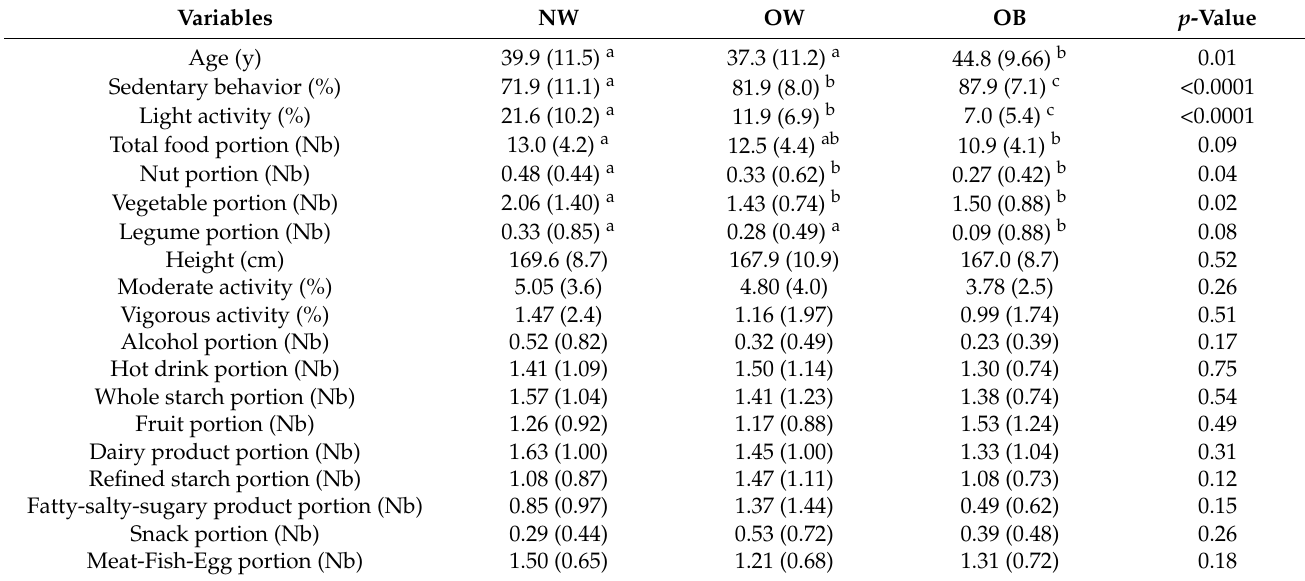
Table 2. Mean comparison between the three weight statuses (NW, OW and OB; n =